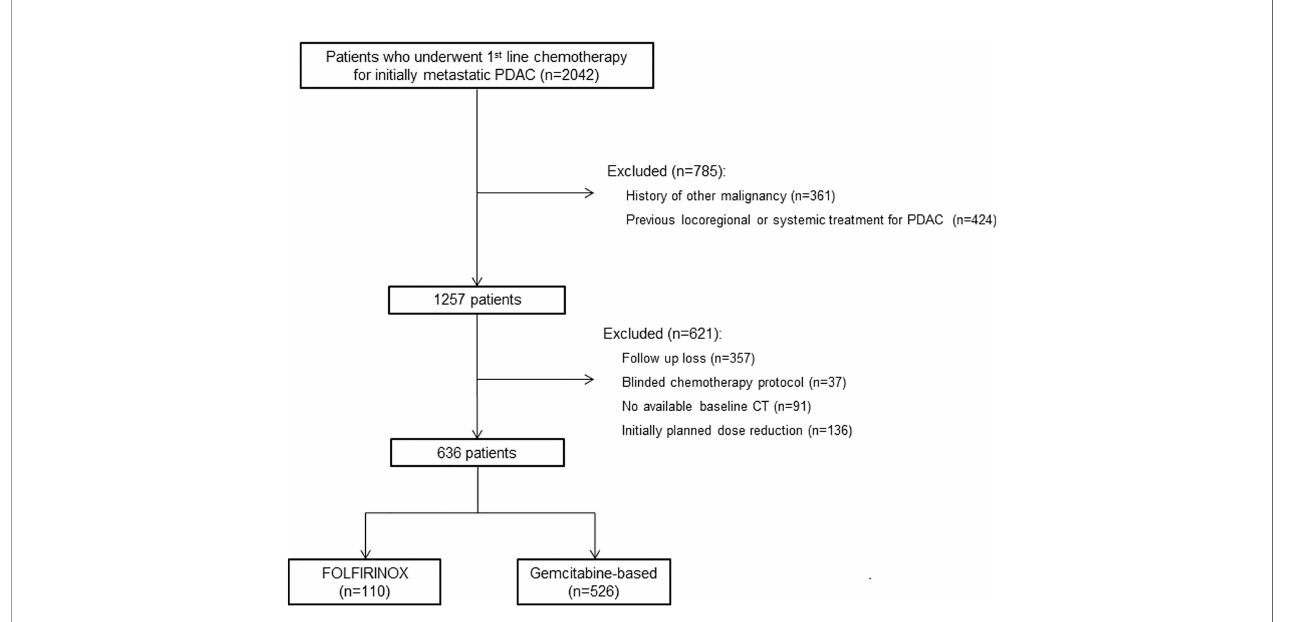
FIGURE 1 | Flow diagram of study population. PDAC , pancreatic ductal